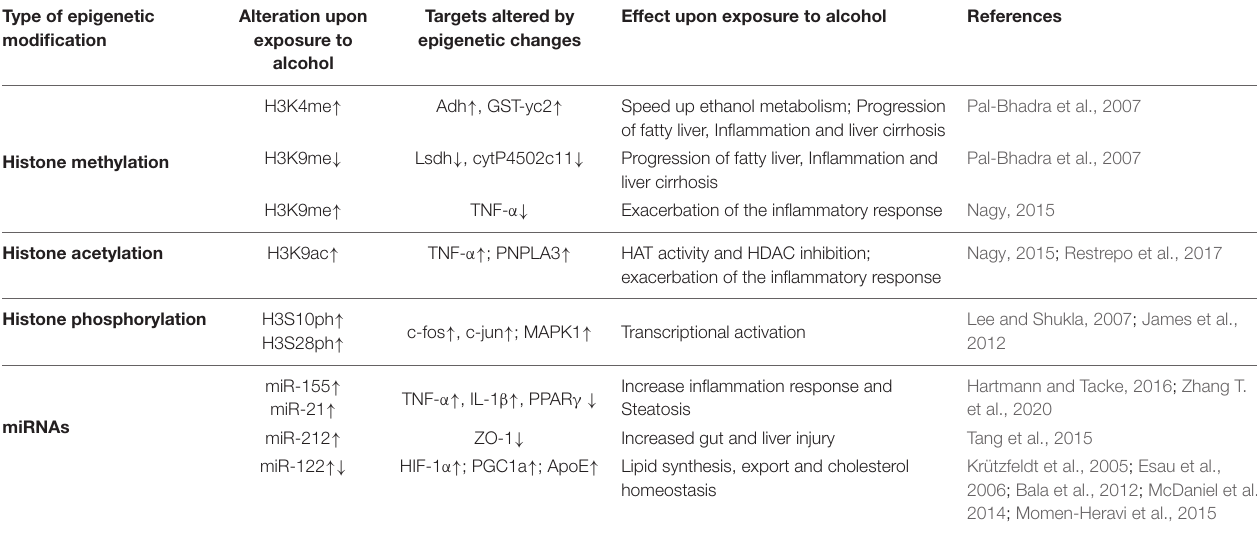
TABLE 1 | Summary of histone modifications and miRNAs involved in